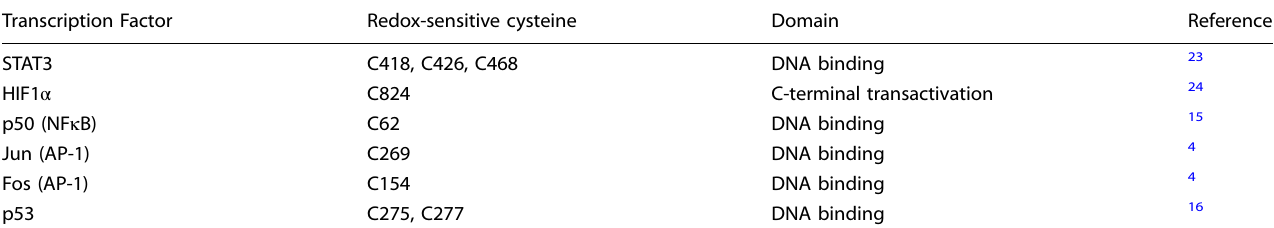
Table 1. Redox-sensitive cysteine residues in transcription